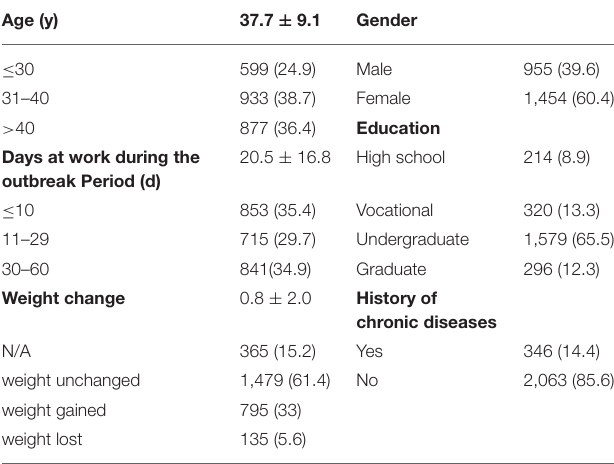
TABLE 1 | Demographic characteristics of the participant population, n = 2,409 ( n ,